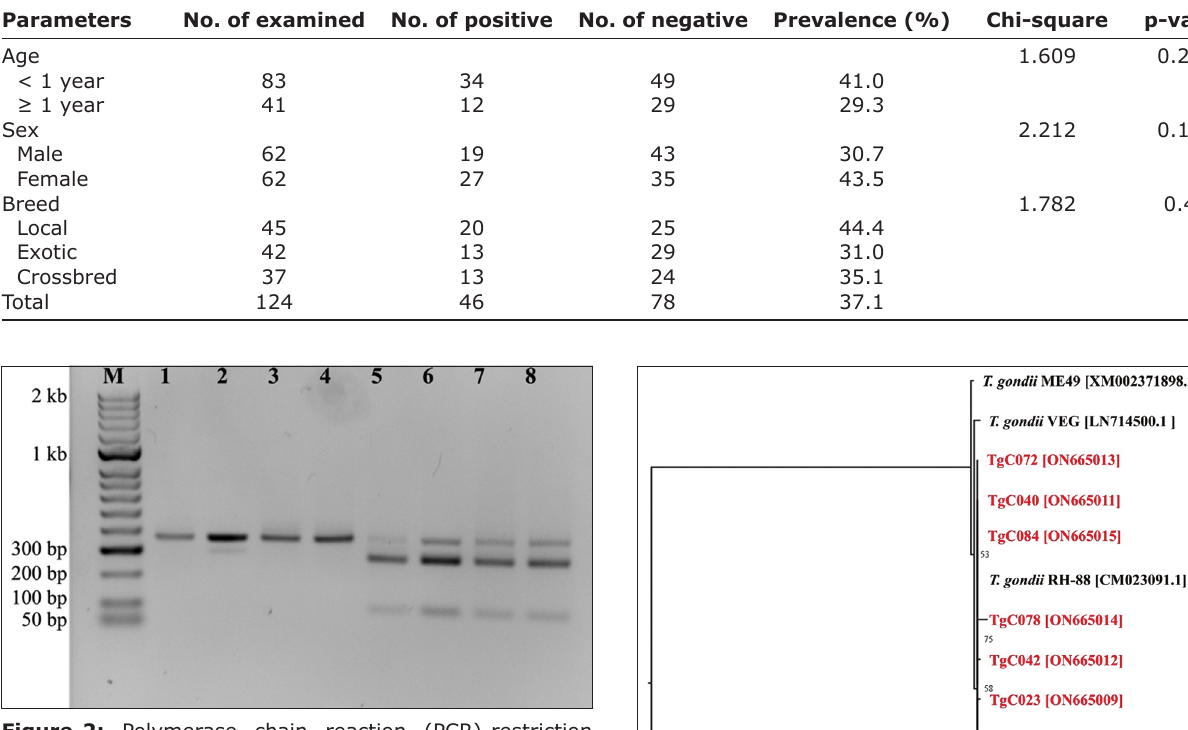
Figure-2: Polymerase chain reaction (PCR)-restriction fragment length polymorphism patterns for granule antigen 6 (GRA6) Toxoplasma gondii PCR products from domestic cats in Phayao, Thailand. Lane M: DNA markers; lanes 1–4: Undigested PCR product of GRA6 positive samples; lanes 5–8: MseI -digested GRA6 with a type I T. gondii genotype.